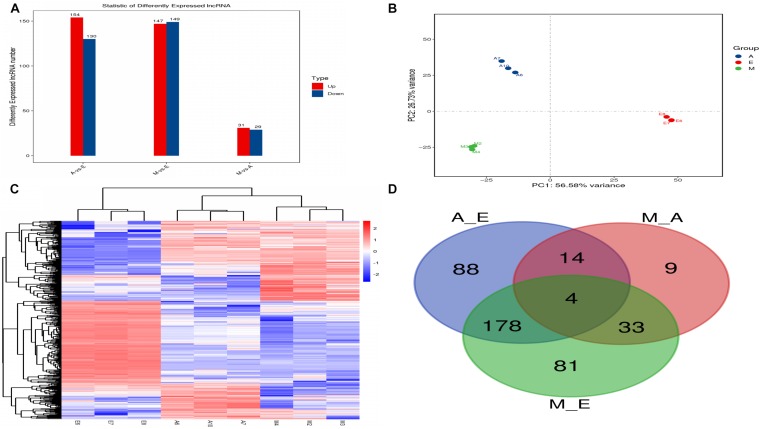
The number of differentially expressed lncRNAs in (control/experiment) A/E, M/A, and M/E comparisons. (A) Total number of differentially expressed lncRNAs in each comparison. (B) Principal component analysis of nine muscle samples. (C) The hierarchical clustering of differentially expressed lncRNAs. (D) Venn diagram showing the distribution of differentially expressed lncRNAs.